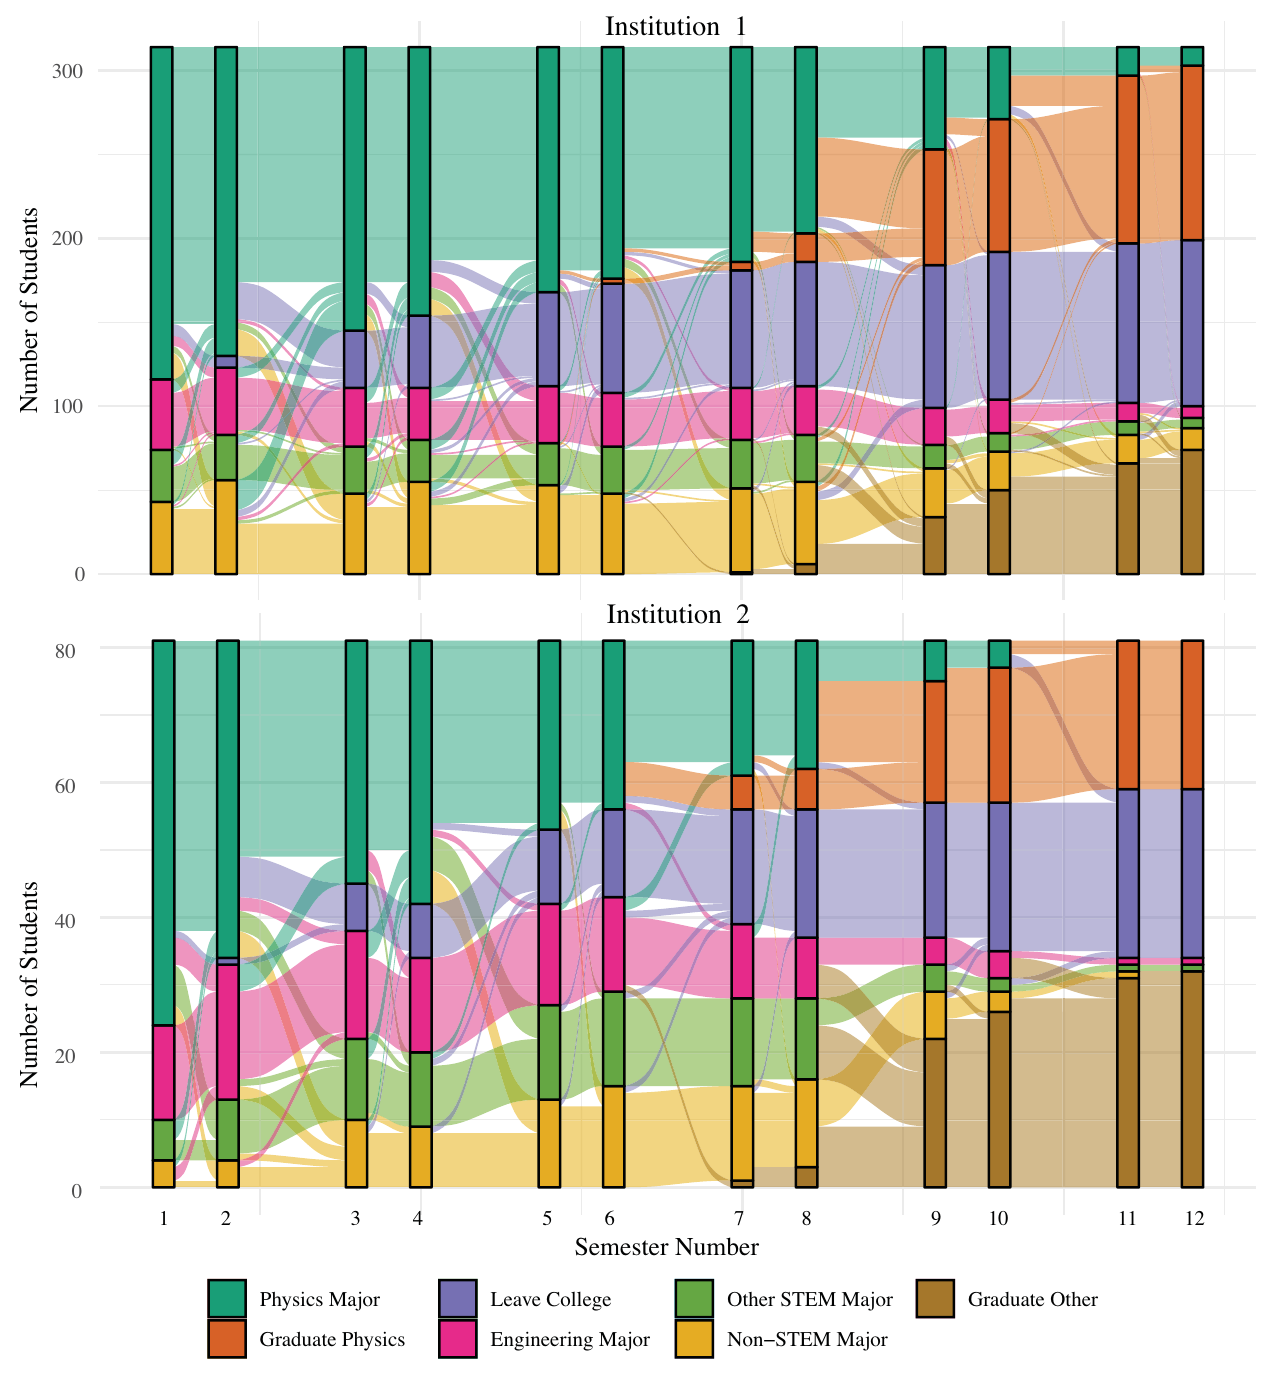
FIG. 1. Sankey plot showing major changing and graduation patterns for students who elect a physics major at any point in their undergraduate career. Each group of two bars represents an academic year; fall semesters are odd numbers, spring semesters